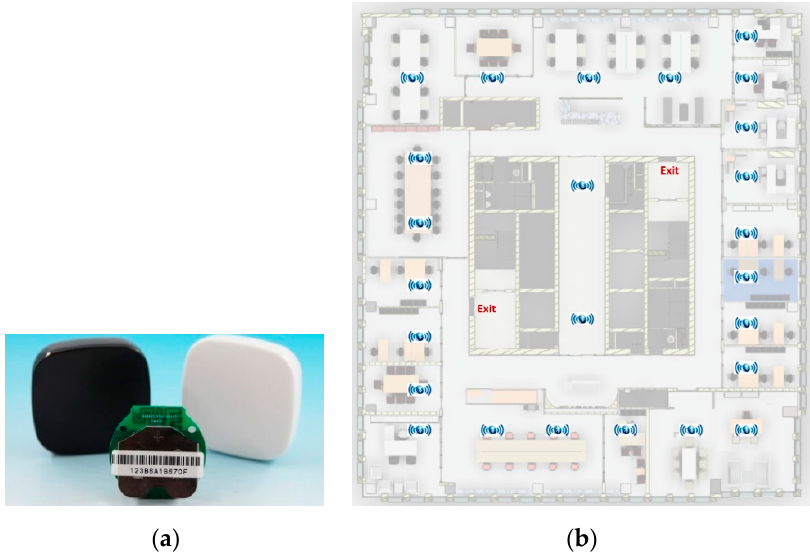
Figure 6. ( a ) Bluetooth sensor employed in this study, ( b ) layout of 26 Bluetooth sensors.